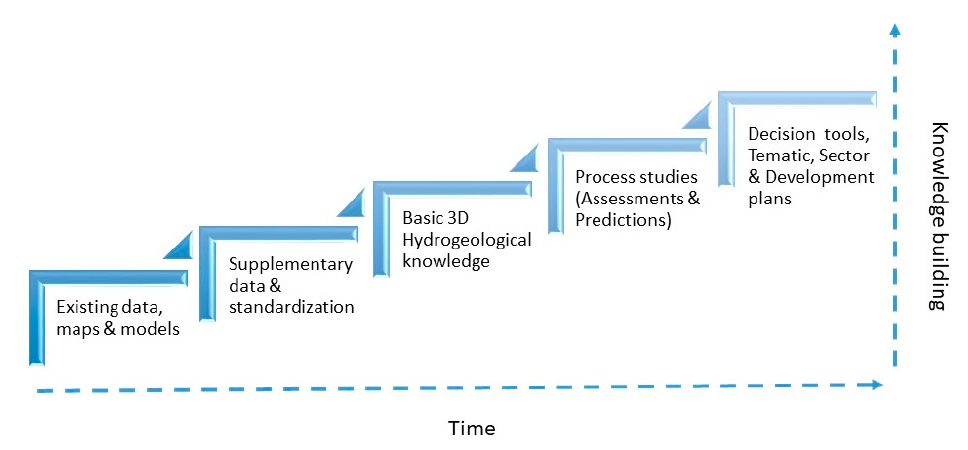
Figure 2. Urban hydrogeology system with step-wise knowledge building process: from screening existing data to development of decision-making tools and plans.